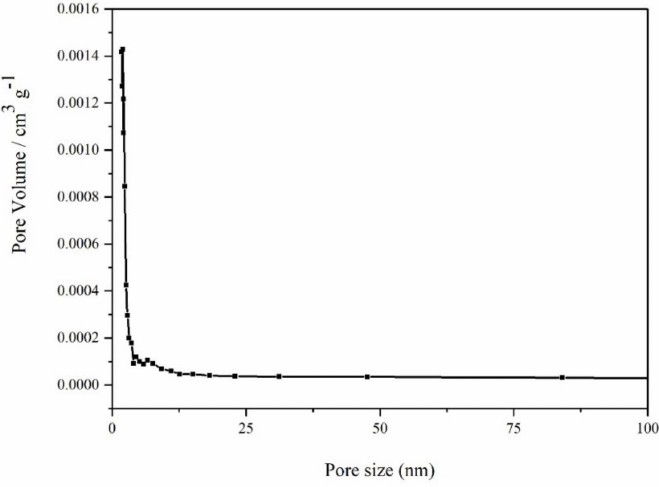
Figure 3. Pore size distribution of tantalum-niobium slag.